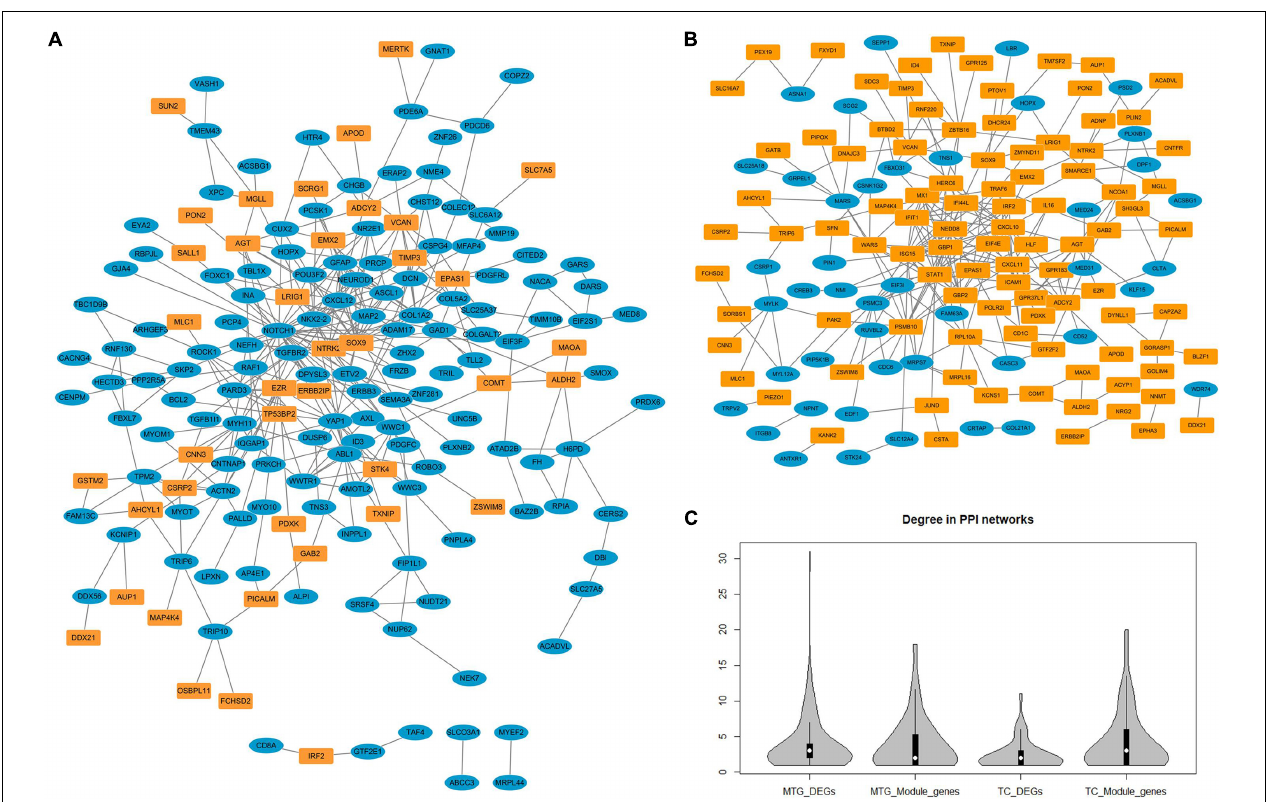
FIGURE 6 | The protein–protein interaction networks constructed by differentially expressed genes and genes in non-preserved modules. (A) Protein-protein interaction network constructed by middle temporal gyrus differentially expressed genes (blue nodes) and non-preserved module genes (yellow nodes). (B) Protein–protein interaction network constructed by temporal cortex differentially expressed genes (blue nodes) and non-preserved module genes (yellow nodes). (C) The degree distribution of different types of genes in protein-protein interaction